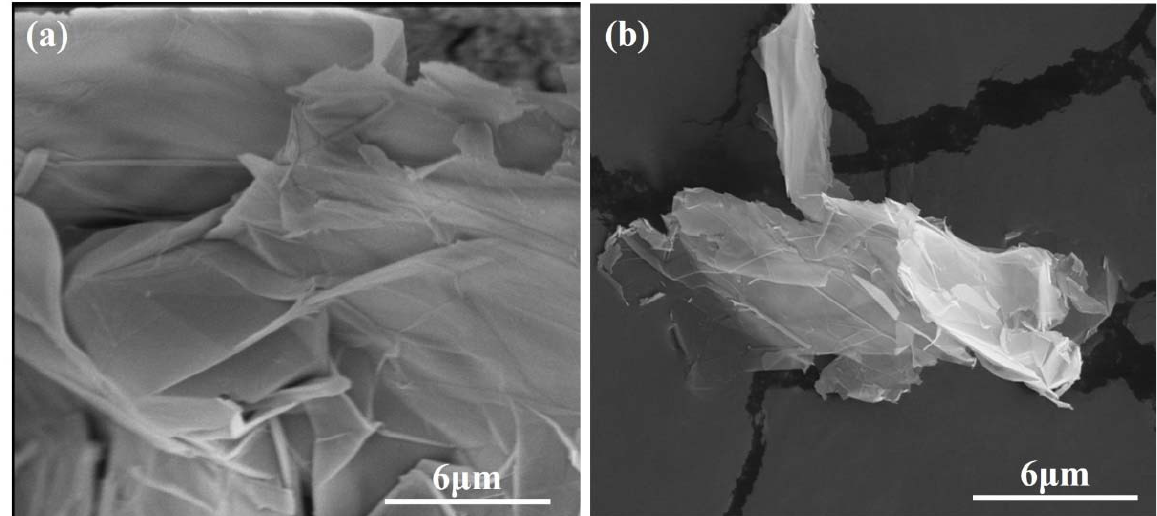
Figure 3. The dispersion of GNPs: ( a ) UV ‐ VIS of GNPs dispersions; ( b ) absorbance of GNP disper ‐ sions.